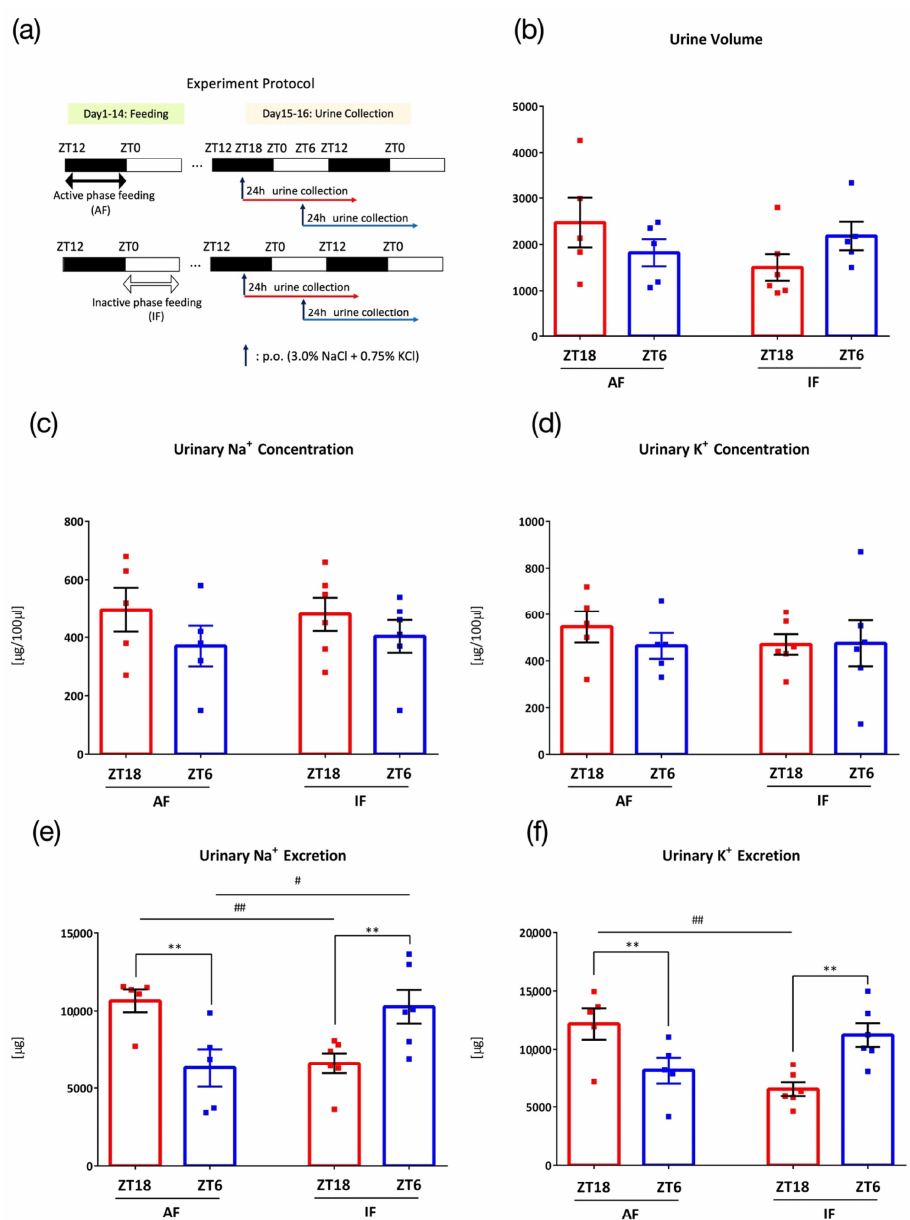
Figure 6. Urinary excretion after administration of salt load under time-restricted